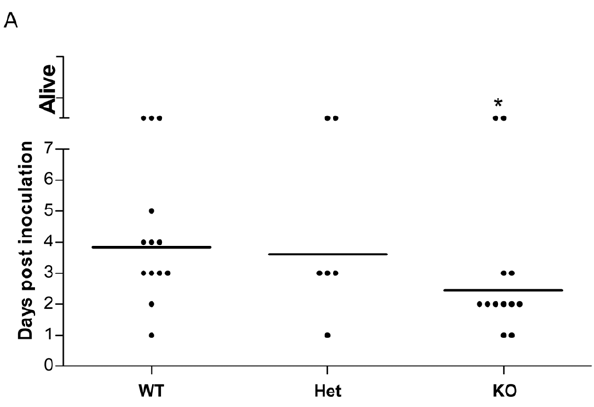
Figure 1. Survival of mice after intranasal inoculation with S. pneumoniae . (A) Ncr1 + / + (WT, n=13), Ncr1 + /gfp (Het, n=6) and Ncr1 gfp/gfp (KO, n=12) C57BL/6 mice were challenged intranasally with high lethal dose of S. pneumoniae strain WU2 in 25 m l PBS. Survival was